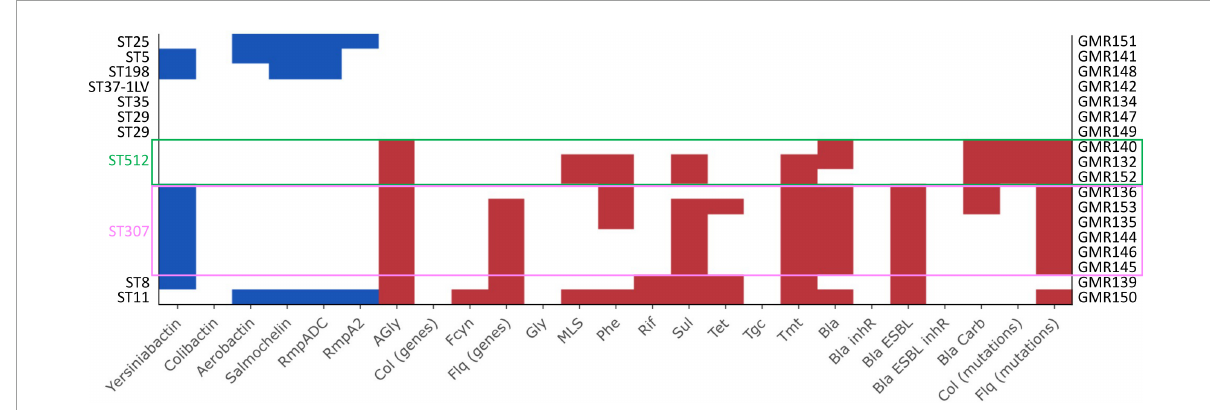
FIGURE2 Results of Kleborate pipeline visualized with the Kleborate-viz tool. Detected resistance determinants are in red while virulence factors are in blue. Legend: AGly_acquired (aminoglycosides), Bla_acquired (beta-lactamases), Bla_inhR (beta-lactamases with resistance to beta-lactamase inhibitors), Bla_Carb (carbapenemase), Bla_ESBL (extended spectrum beta-lactamases), Bla_ESBL_inhR (extended spectrum beta-lactamases with resistance to beta-lactamase inhibitors), Fcyn (fosfomycin), Flq (fluoroquinolones), Gly (glycopeptides), MLS (macrolides), Phe (phenicols), Rif (rifampin), Sul (sulfonamides), Tet (tetracyclines), Tmt (trimethoprim), Tgc